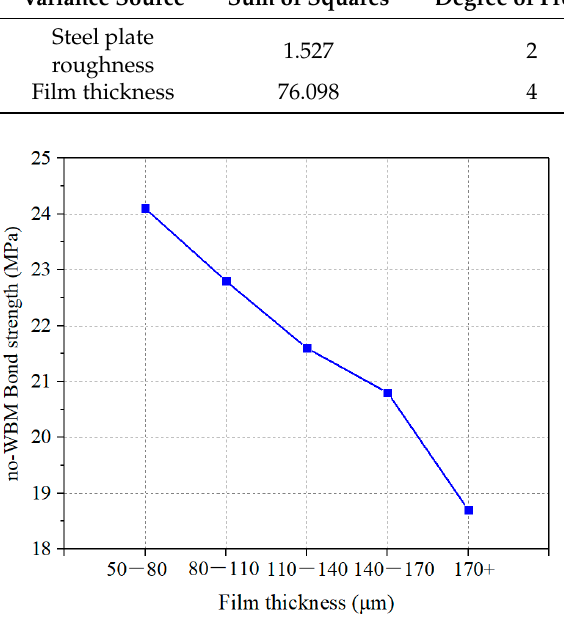
Table 12. Results of two-factor ANOVA of no-WBM bond strength.